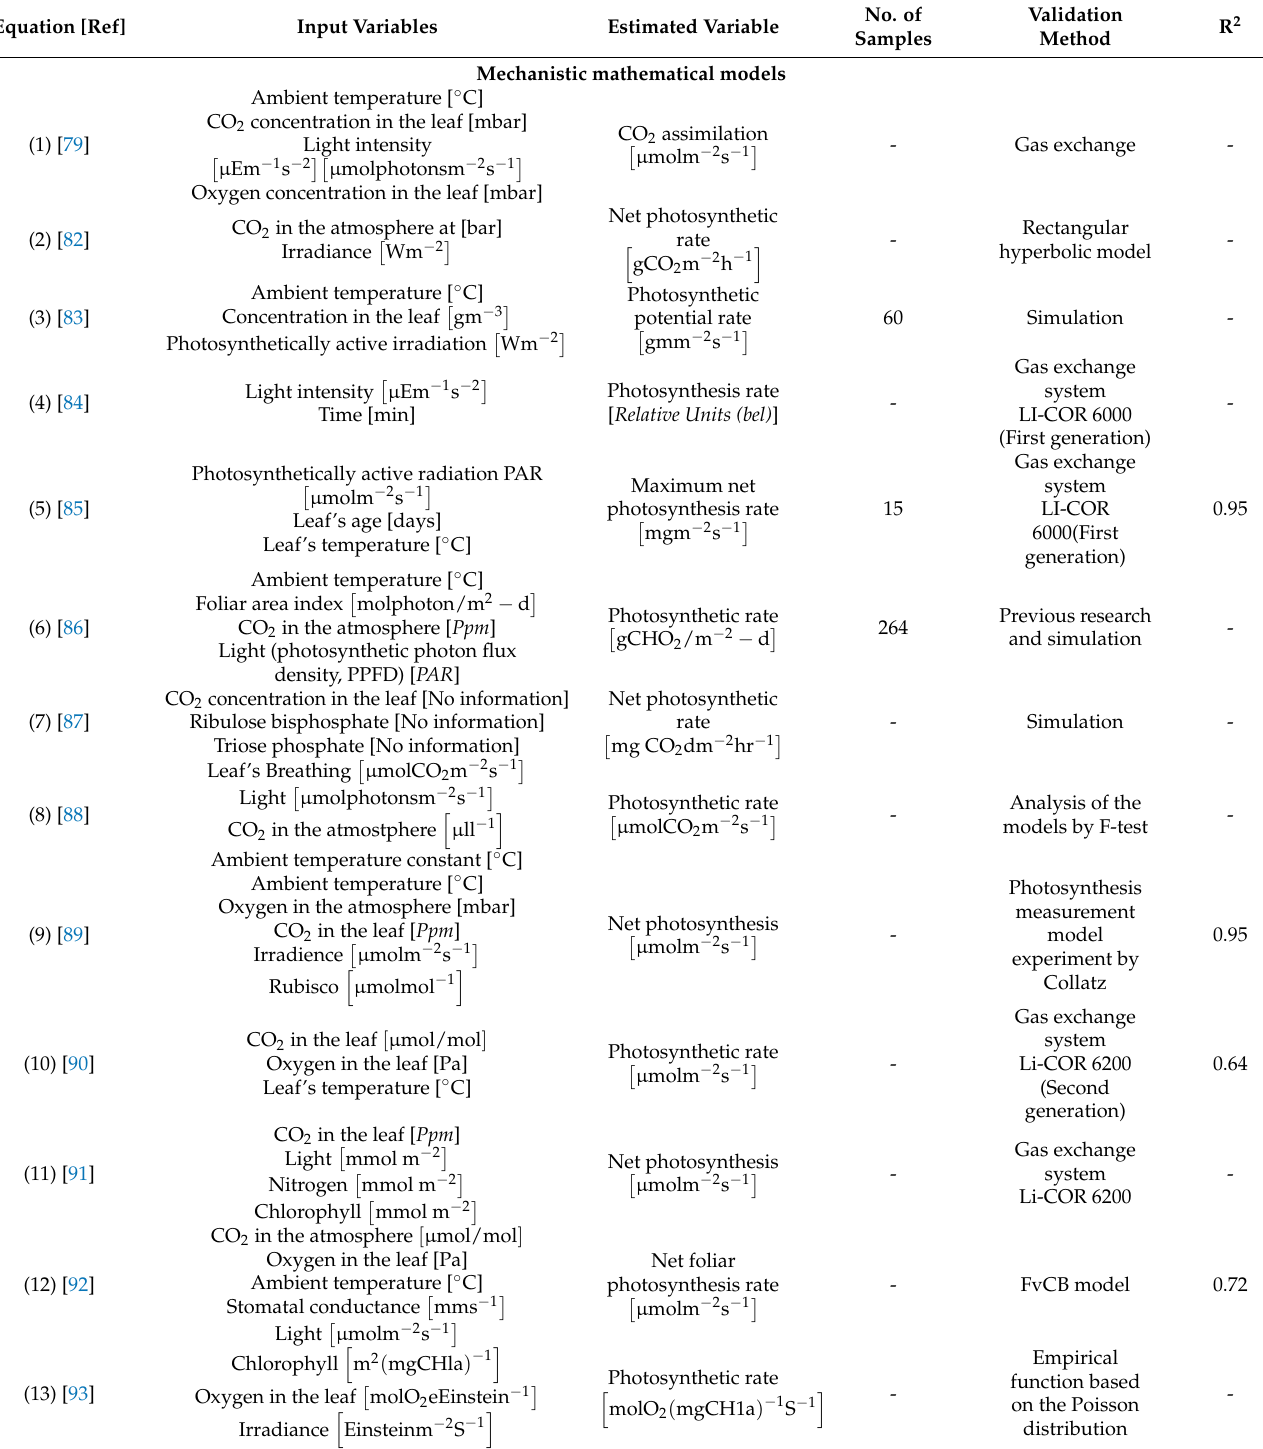
Table 3. Major features of the models for estimating